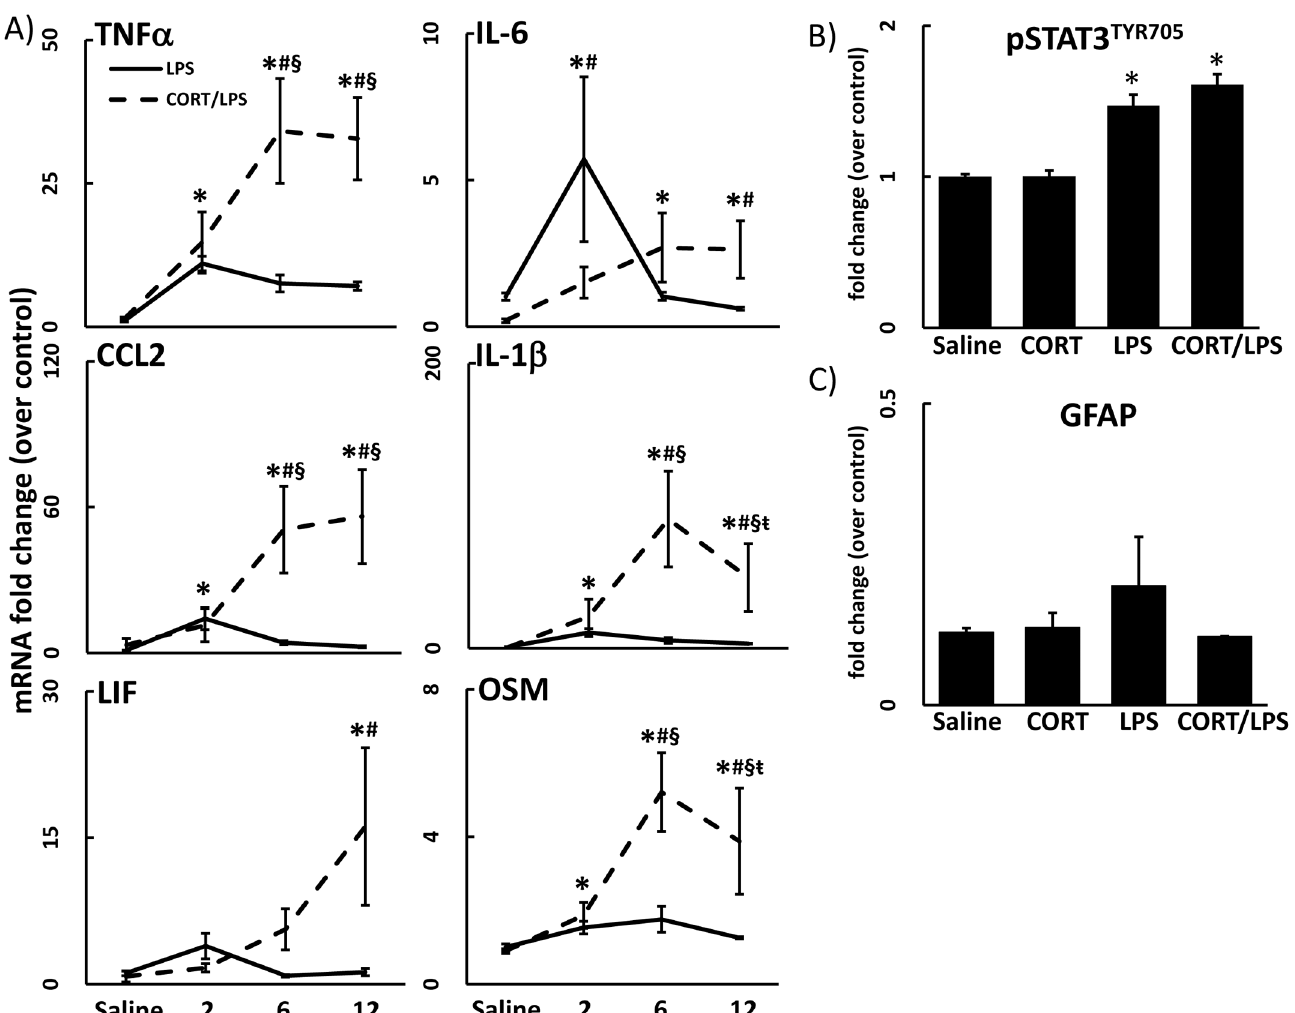
Fig 3. Chronic CORT pretreatment exacerbates and prolongs LPS-induced neuroinflammation but has no effect on activation of STAT3 and does not cause astrogliosis. A) A time course of LPS (2 mg/kg, s.c.)-induced neuroinflammation with and without CORT pretreatment (200 mg/L 0.6% EtOH in drinking water for one week) is shown (saline, 2, 6 and 12 hours). TNF α , IL-6, CCL2, IL-1 β , LIF, and OSM mRNA levels were measured in samples prepared from cortex. Data represents mean ± SEM (n = 5 mice/group). CTX data for LPS alone treated groups are included from Fig 1A for statistical comparison. Statistical significance of at least p < 0.05 is denoted by (cid:3) as compared to control, # as compared to LPS alone, § as compared to 2h CORT/LPS, and as compared to 6h CORT/LPS. B & C) Effects of chronic CORT pretreatment (200 mg/L 0.6% EtOH in drinking water for one week) on LPS induced activation of the STAT3 signaling module was assessed by immunoblots of pSTAT3 Tyr705 and astrogliosis was assessed by immunoassay of GFAP. Cortex samples were analyzed for pSTAT3 Tyr705 (6 hours) and GFAP protein (72 hours) after LPS exposure of CORT pretreated animals. Data represent mean ± SEM (n = 5 mice/group). Saline and LPS alone treated groups are included from Fig 1B & 1C for statistical comparison. Statistical significance of at least p < 0.05 is denoted by (cid:3) as compared to control, # as compared to LPS